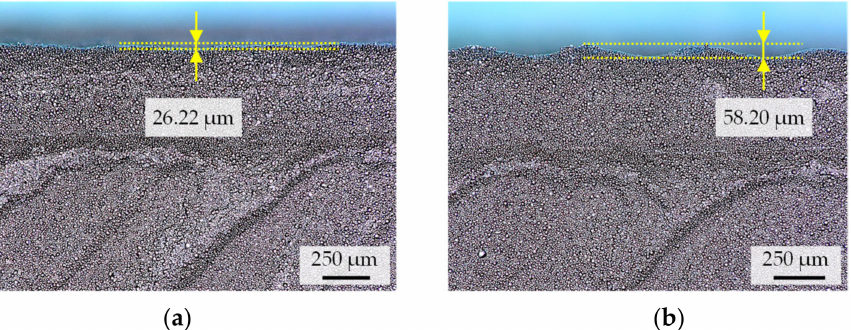
Figure 11. Digital images of the test specimen edge in x-y-plane: ( a ) T = 95 ◦ C, v c = 8 mm/s, F e = 1300 N; ( b ) T = 95 ◦ C, v c = 12 mm/s, F e = 1700